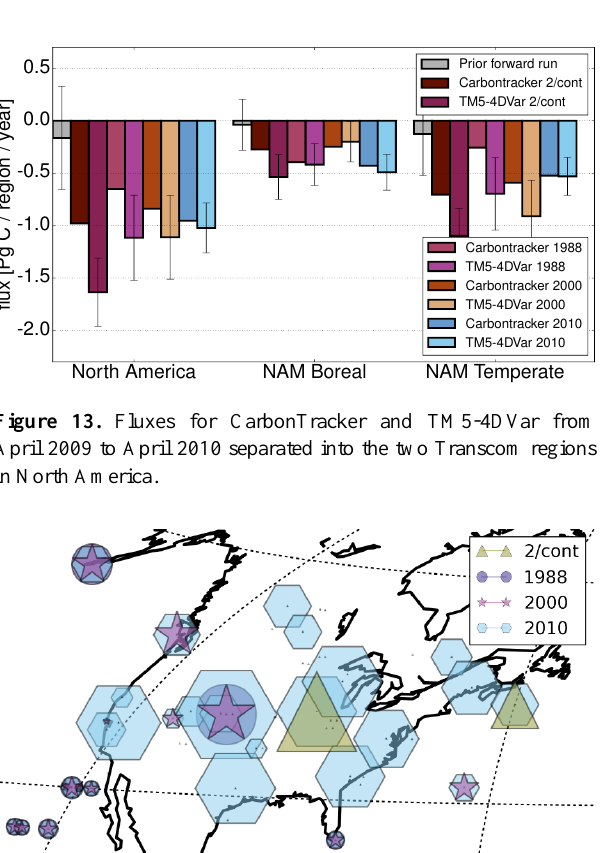
Figure 14. Visualization of the weight of the measurement sites which are assimilated in North America in the respective